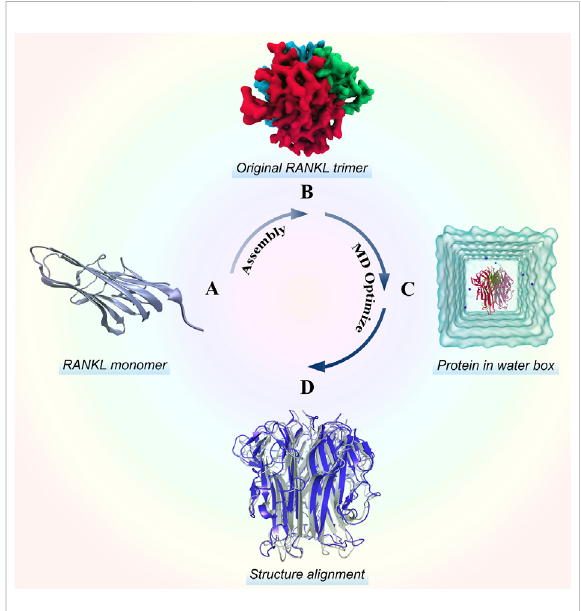
FIGURE 1 Stereo structure modelling of the RANKL trimer. (A) Structure of the RANKL monomer, which has a typical jellyroll-like β -sheet structure. (B) OriginalRANKLtrimerstructuremodelledbyrotating symmetric polymeric docking in M-ZDOCK online server. (C) Optimized RANKL trimer structure obtained by MD simulation. (D) Alignment of optimized structure and original structure, in which the structure colored in blue represents the optimized model and the structure colored in grey represents the original